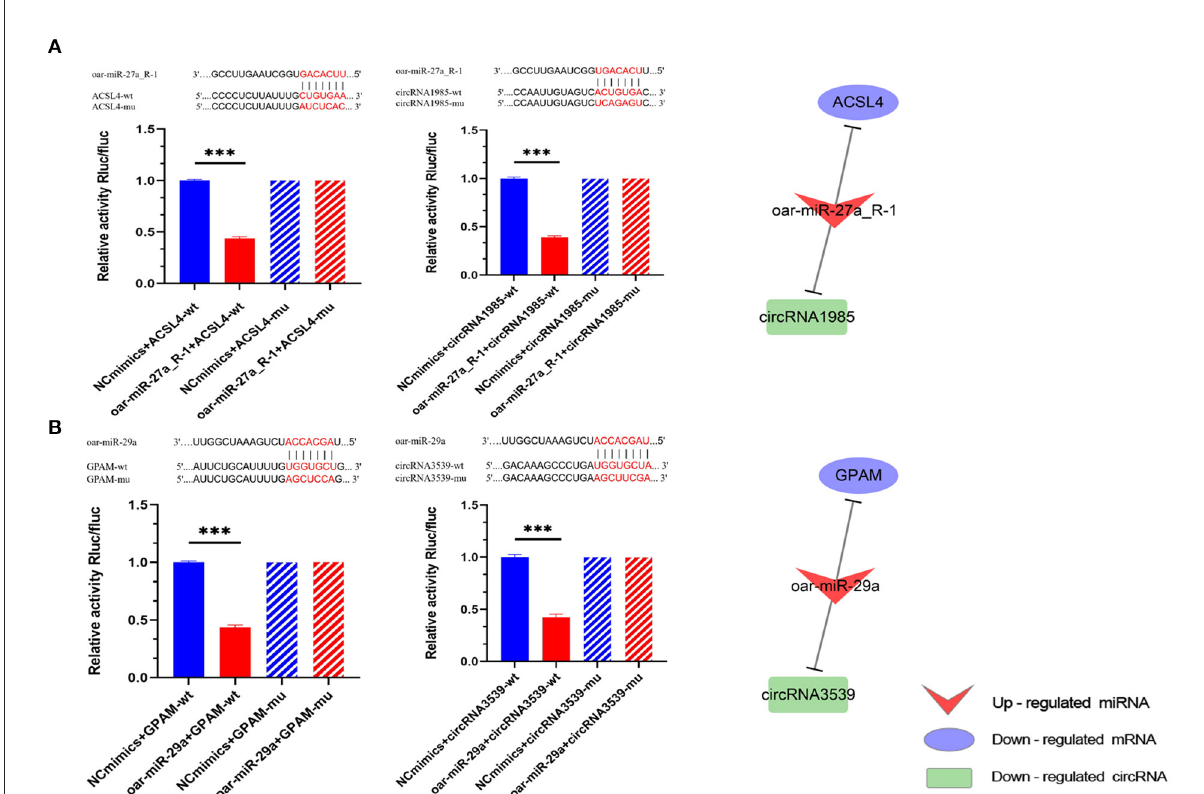
FIGURE8 ceRNA dual-luciferase reporter gene analysis. (A) Binding site validation for oar-miR-27a_R-1 and ACSL4 as well as oar-27a_R-1 for circRNA1985; (B) Binding site validation for oar-miR-29a and GPAM as well as oar-miR-29a and circRNA3539. Bars without slashes show the result of inserting the mutant sequence into the plasmid, while solid bars show the result of inserting the original sequence. The group with extra miRNA sequences is shown in red, and the group without any miRNA sequences (control group) is shown in blue. *** P <